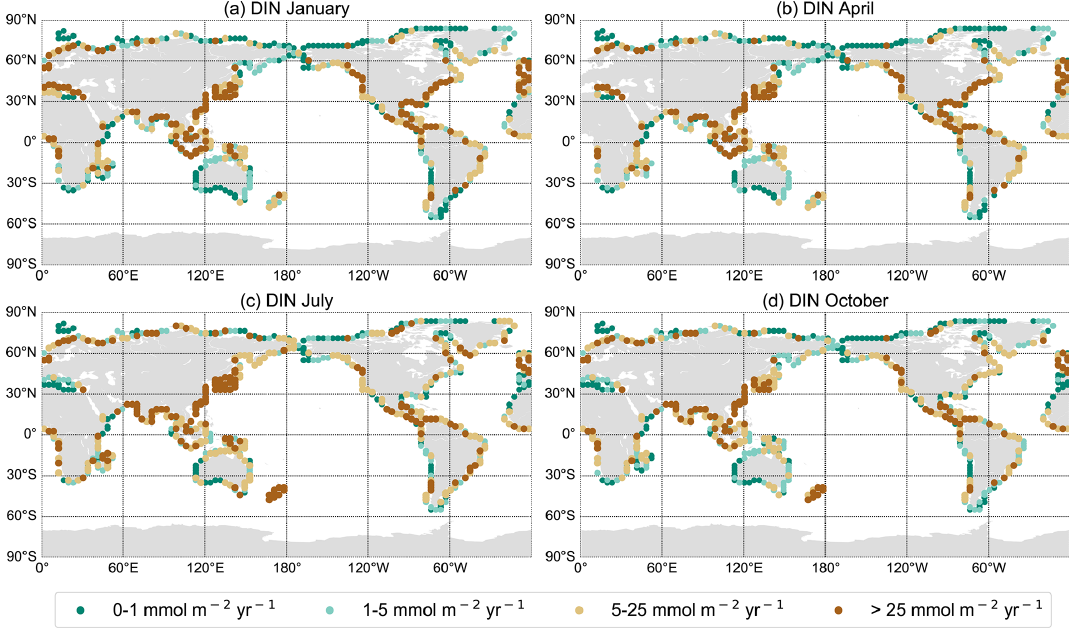
Figure 2. DIN export yield for each discharge point inmmolm − 2 yr − 1 from the NEWS 2 data set interpolated on the UVic grid for January (a) , April (b) , July (c) , and October (d)